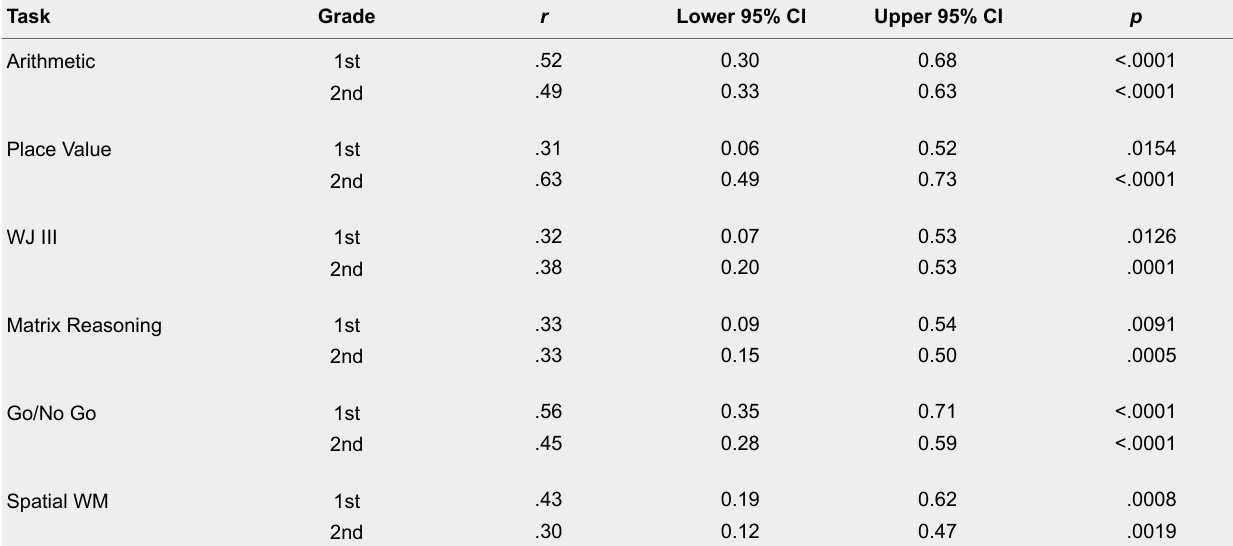
Test-Retest Correlations Within Task and Grade